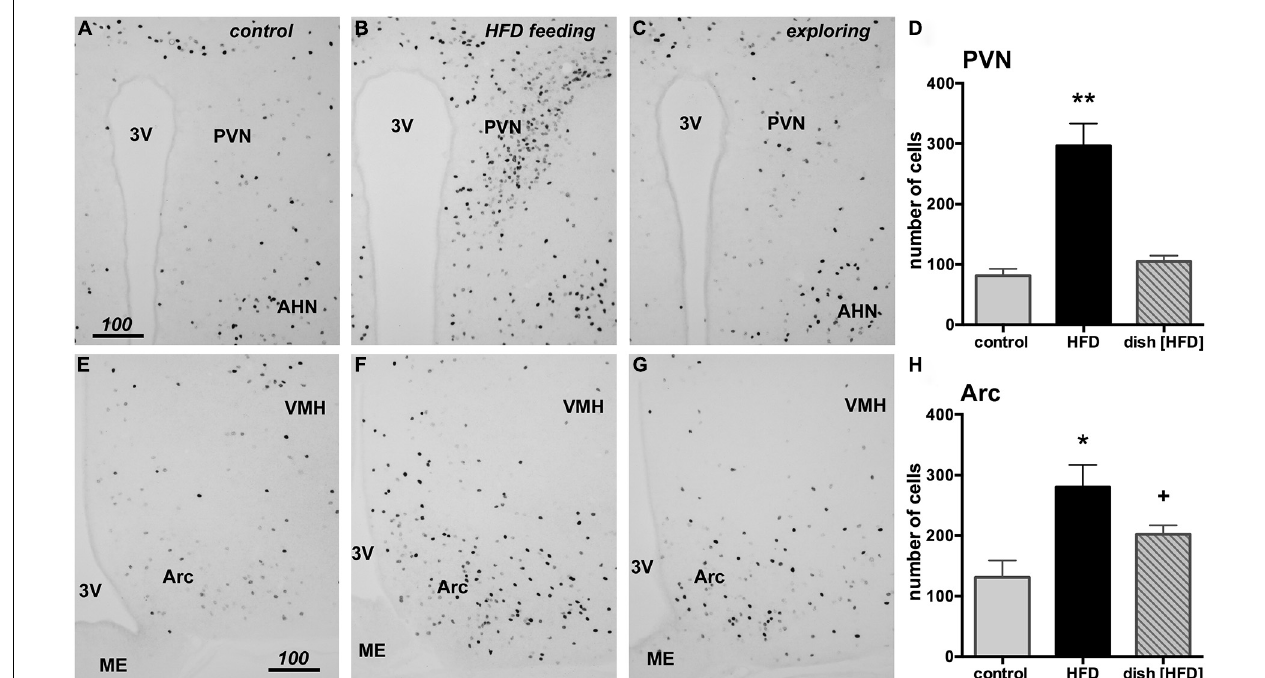
exploratory behavior (C,G) . HFD feeding led to a significant increase in Fos in the PVN ( D , ** p < 0.05) and the Arc ( H , * p < 0.05). No change in fos expression was observed in the PVN of the food driven exploratory behavior group ( D , dish [HFD]) while a small, yet statistically insignificant increase was noticeable in the Arc ( H , + ). Scale bars in A,E = 100 μ m and also applies to panels B,C and F,G